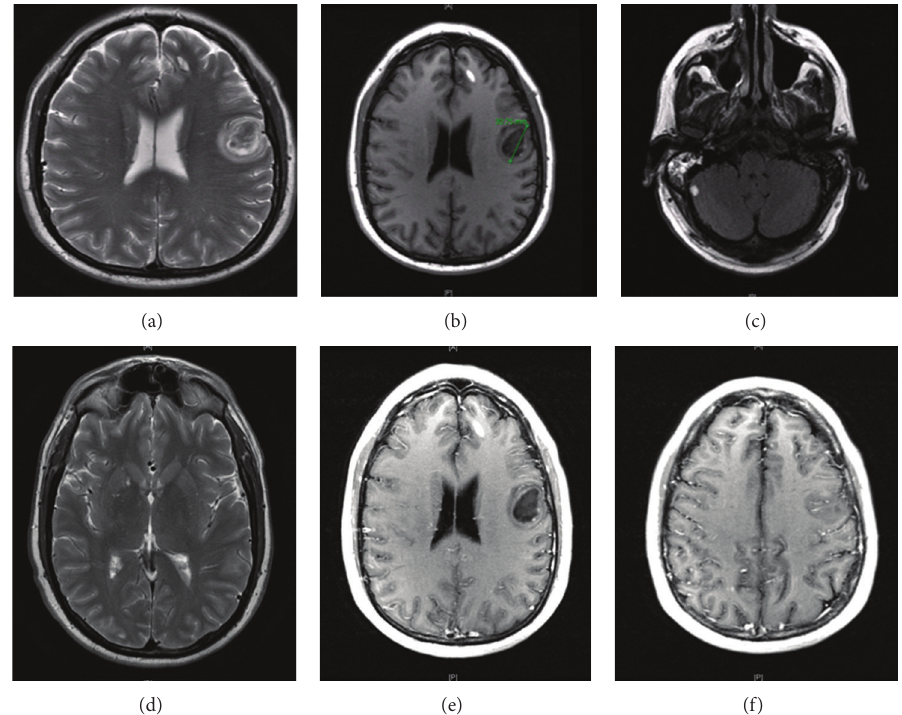
the dominant focus is measuring 3.1 cm in left frontal lobe, presumably a focus of most acute hemorrhage, and posterior fossa contains a single focus of abnormal T1 signal presumably of the same etiology.